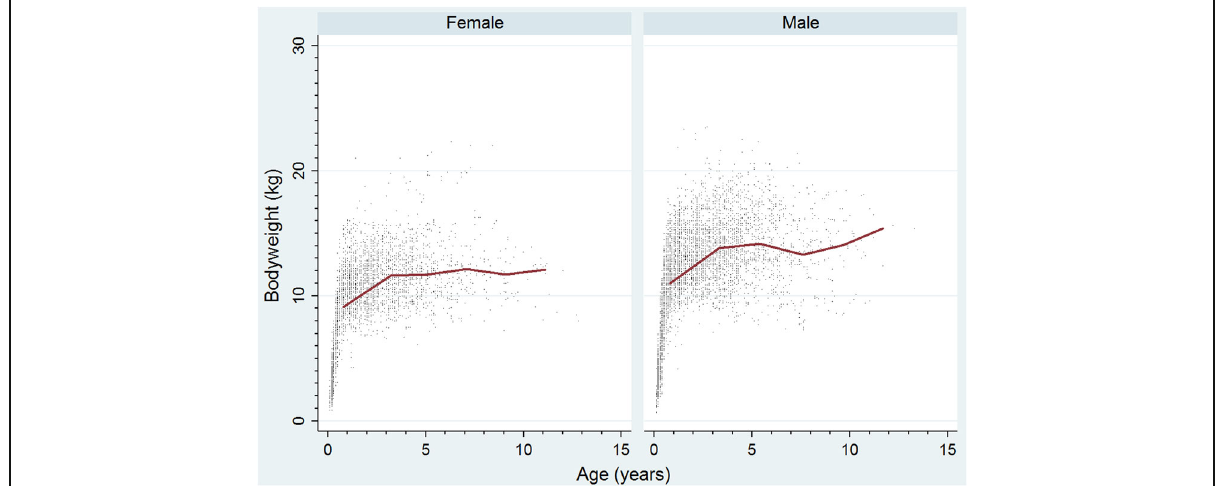
Fig. 2 Bodyweight growth curves overlaid with a cross medians line plot for female and male French Bulldogs attending UK primary-care veterinary clinics participating in the VetCompass ™ Programme. (Weight values: Females n =3413, Males n